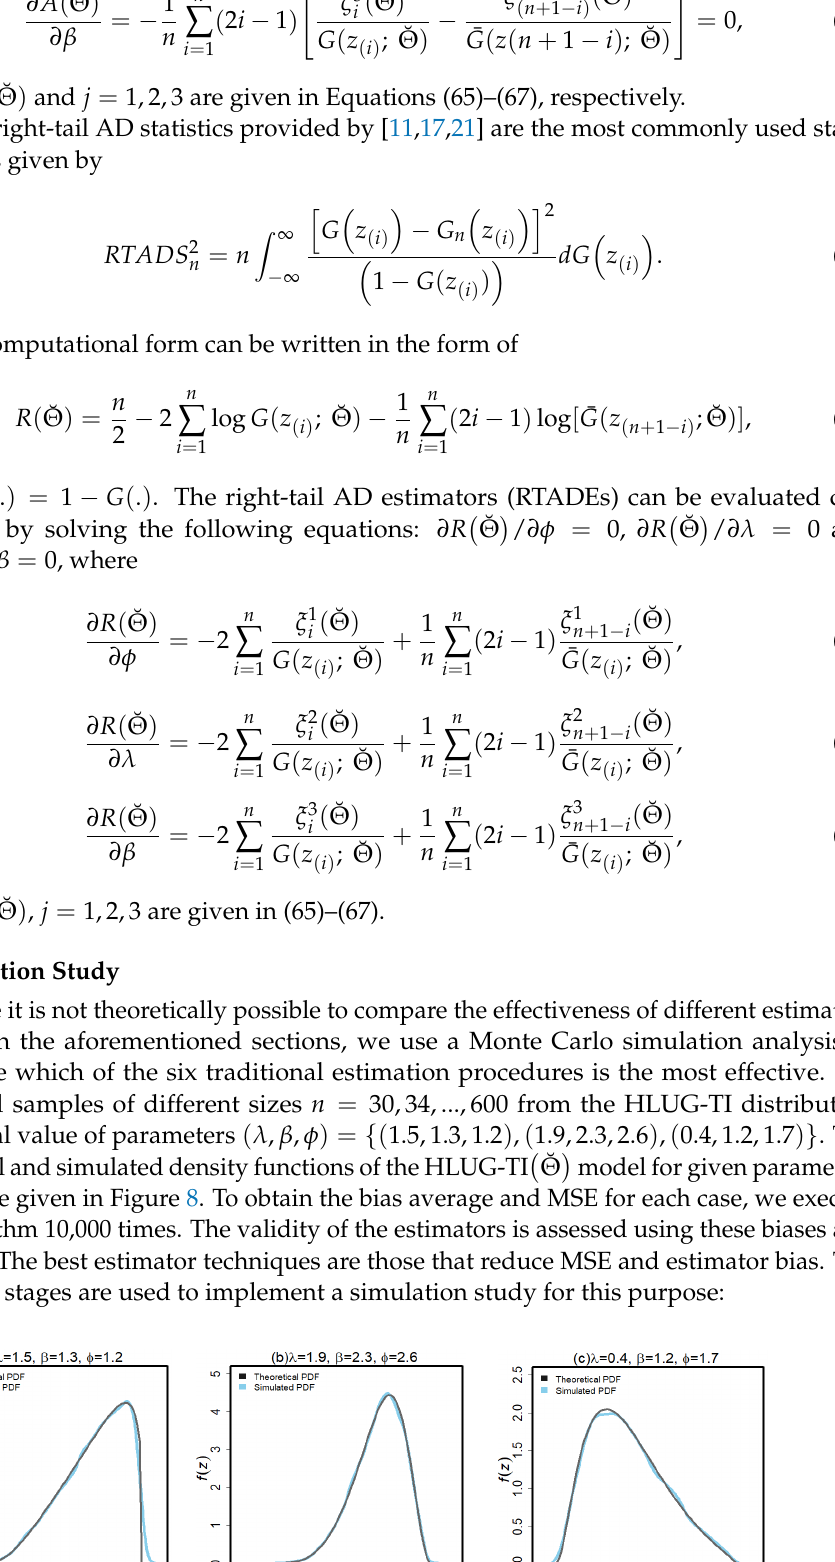
Fig. 9. Plots of biases and MSEs for the parameters (cid:21) = 1 : 5 ; (cid:12) = 1 : 3 and (cid:30) = 1 : 2 of HLUG-TI model.